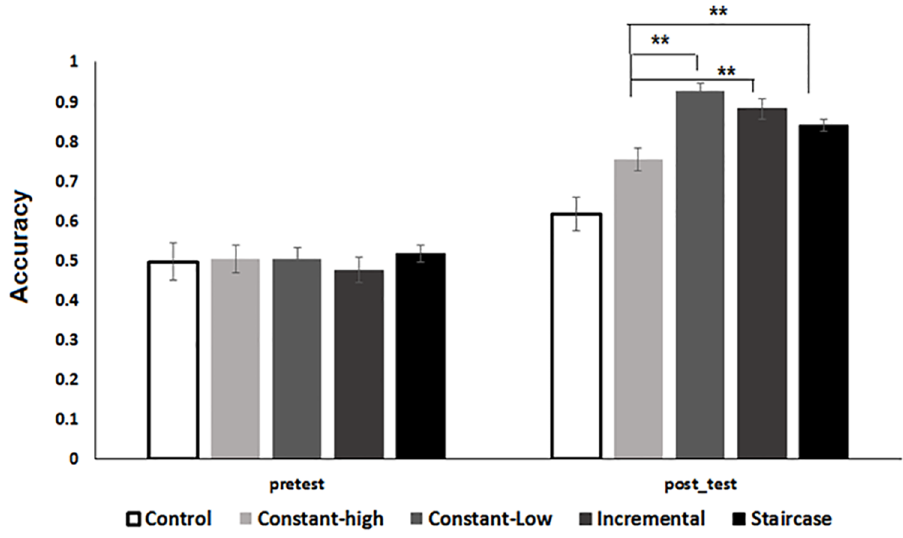
Fig 2. Pre-test and post-test performance on the trained condition as a function of group. Error bars show the 95% confidenceinterval of the mean. ** p < .01 in betweengroup t-tests on post-test data.